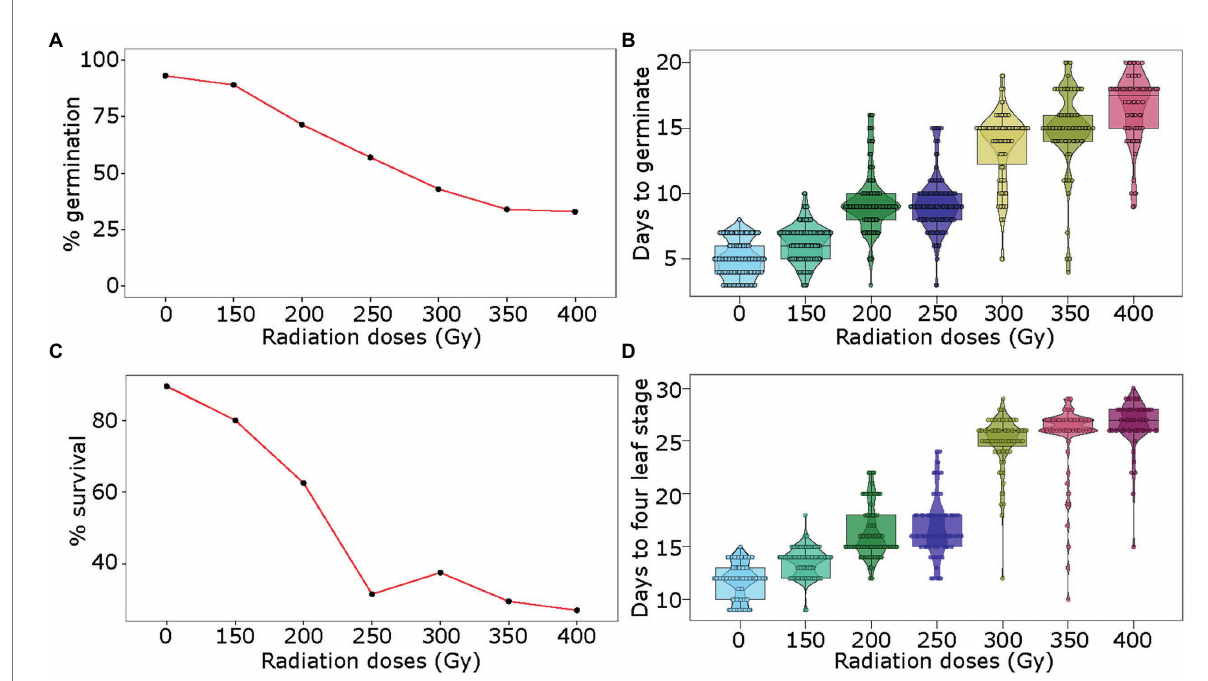
FIGURE 2 Optimization of gamma radiation treatment for mutagenesis of pea seeds. Seeds of pea genotype CDC Amarillo were treated with different doses of gamma radiation and were grown in the growth chamber. The germination rate (A) , days to germination (B) , survival rate (C) , and days to fourth-leaf stage (D) were assessed in treated and control samples to identify an optimal dose of gamma radiation for mutagenesis of pea